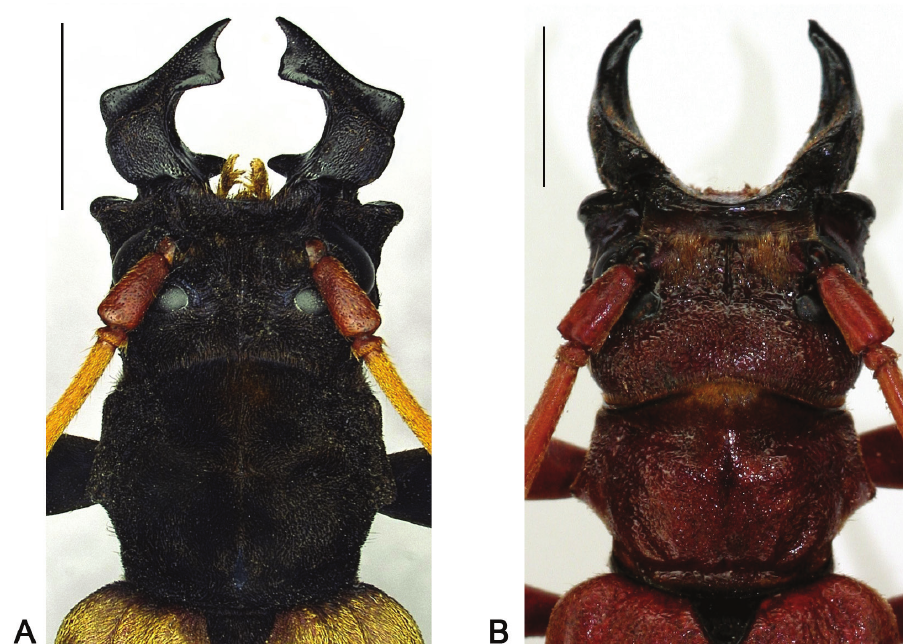
Figure 2. Dorsal view head and pronotum, scale bars 5 mm A Hexamitodera ( Sulcognatha ) blairi comb. n., male, Indonesia, Central Sulawesi, Puncak B Parandrocephalus eversor , male, Malaysia, Cameron Hi- ghlands, Kampong Rajah.